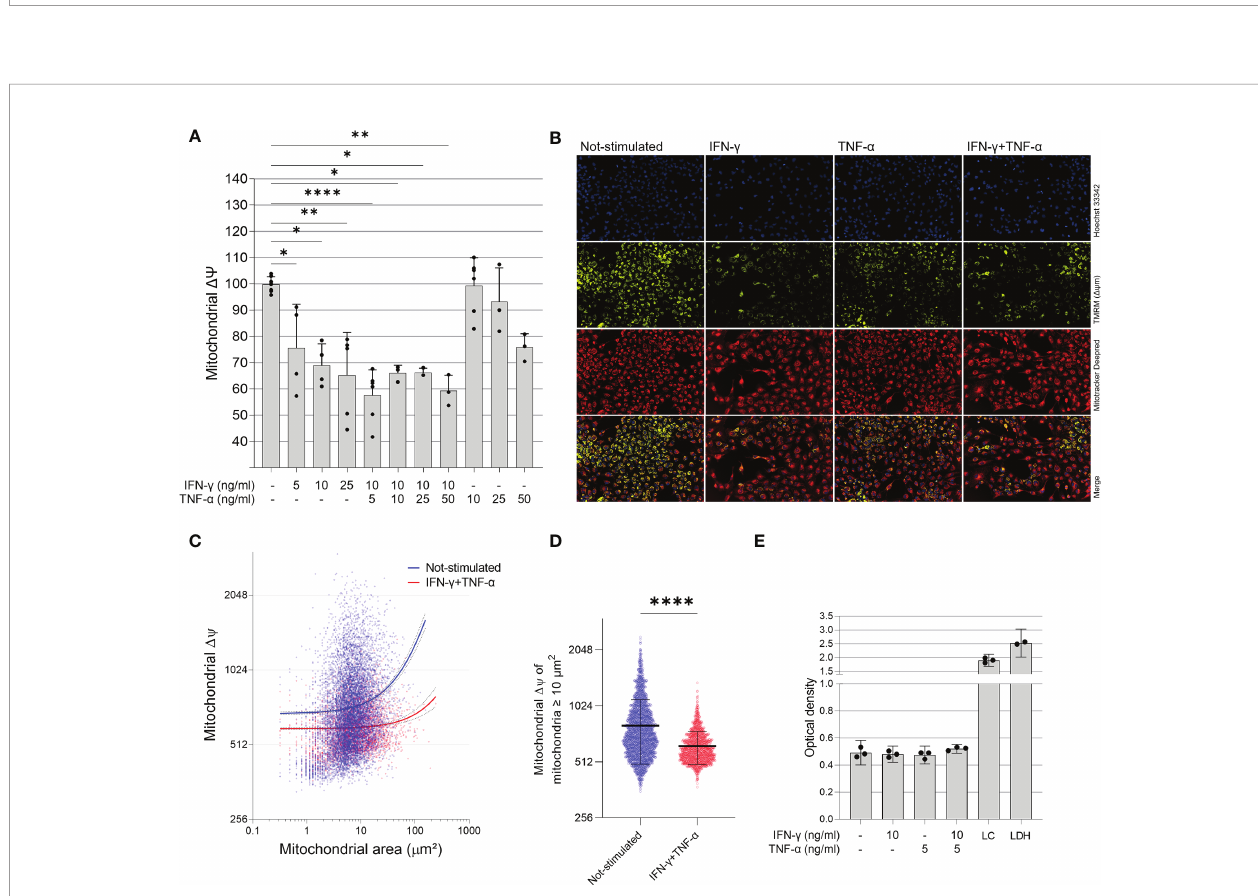
FIGURE 2 | Effect of IFN- g and TNF- a on mitochondrial membrane potential in human cardiomyocytes AC-16 cells. Stimulated cells were multi-labelled with TMRM, Mitotracker DeepRed, NucGreen and DAPI. TMRM fl uorescence was measured when colocalized with the fl uorescence of Mitotracker Deep Red in live cells (NucGreen-negative). (A) IFN- g and IFN- g plus TNF- a downmodulate DY m 48h after stimulation. Data shown as percentage to not-stimulated cells. *p < 0.05; **p < 0.01; ****p < 0.0001; One-way Anova, Dunn ’ s post test. (B) Representative micrographs of the effect of IFN- g (10 ng/ml), TNF- a (5 ng/ml) and both on the fl uorescence of TMRM. Magni fi cation 100x. (C) Correlation between size (µm 2 ) and TMRM fl uorescence intensity of segmented mitochondria of cells stimulated with 10 ng/ml of IFN- g and 5 ng/ml of TNF- a . (D) DY m of mitochondria larger ≥ 10 µm 2 of cells stimulated with 10 ng/ml of IFN- g and 5 ng/ml of TNF- a . ****p < 0.0001 Mann-Whitney test. (E) Supernatant quanti fi cation of lactate dehydrogenase (LDH assay) on stimulated cells. Each dot in bar graphs represents an independent experimental replicate n ≥ 3. LC: lysed AC-16 cells; LDH: lactate dehydrogenase positive